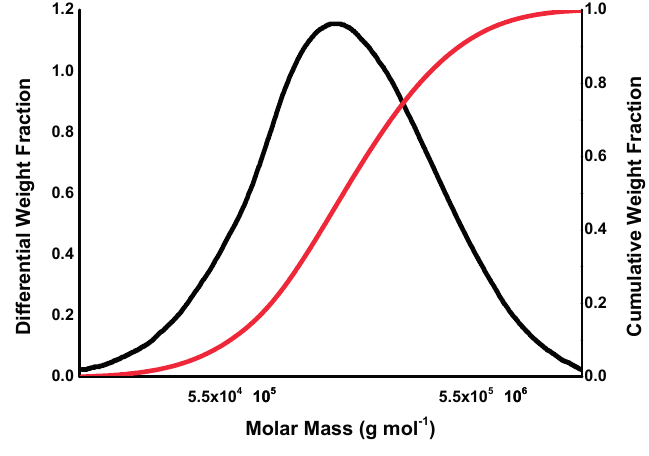
Figure 1. Differential ( black ) and cumulative ( red ) plots of